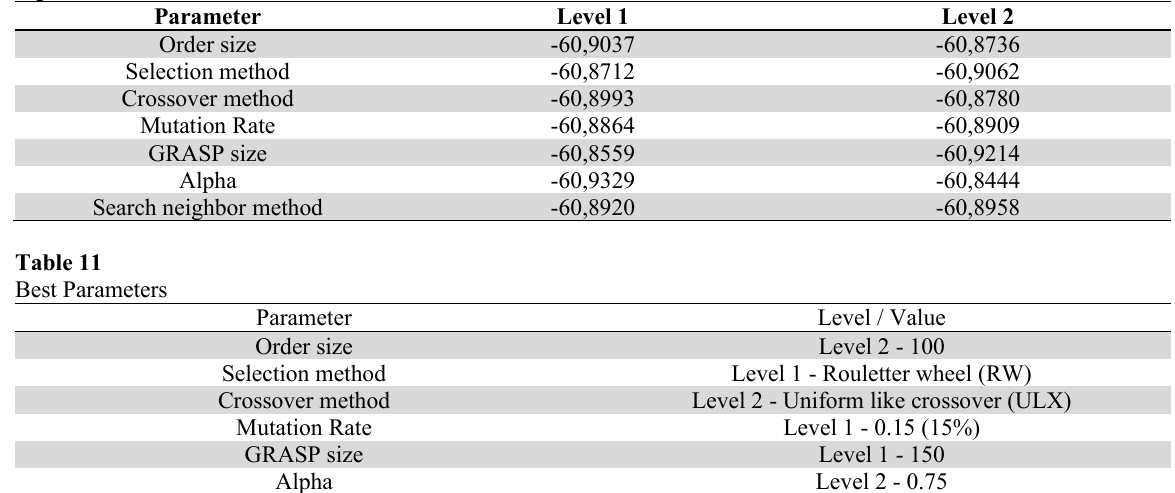
Signal to Noise of Parameters